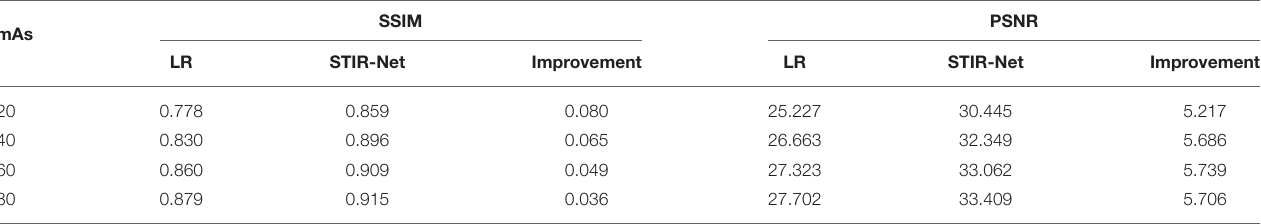
TABLE 2 | Average SSIM and PSNR (dB) performance of seven patients’ 833 slices for XY direction when STIR-Net is trained and tested with mix levels of tube currents, where at a fixed spatial/temporal sampling scale S 2 . SSIM PSNR mAs LR STIR-Net Improvement LR STIR-Net Improvement